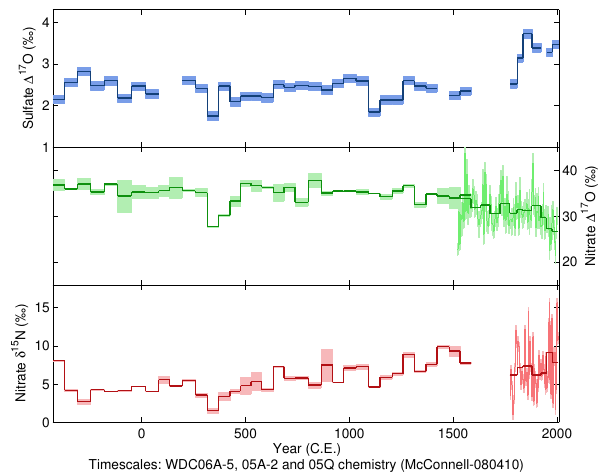
Figure 2. Measurements of 1 17 O ( SO 42 − ) , 1 17 O ( NO 3 − ) , and δ 15 N ( NO 3 − ) in the upper 577m of the WAIS Divide ice core. Each horizontal line segment indicates the time interval of that sam- ple. Shading indicates the measurement uncertainty based on the replicate analysis of standards ( 1 17 O ( SO 42 − ) ) or replicate sam- ple measurements ( 1 17 O ( NO 3 − ) , δ 15 N ( NO 3 − ) ). The recent part of the nitrate isotope records are measured at 1m resolution (see Fig. 4 for an expanded version of this record); the 1m resolu- tion measurements and their analytical uncertainty are shown in thin lines and shading and the thick lines through this portion of the 1 17 O ( NO 3 − ) and δ 15 N ( NO 3 − ) indicate the concentration- weighted isotopic values at the resolution of the 1 17 O ( SO 42 − )